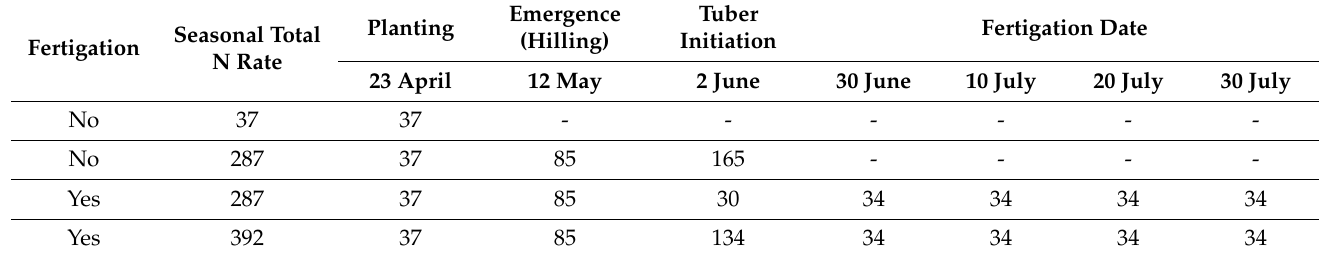
Table 1. Nitrogen treatments and schedule.